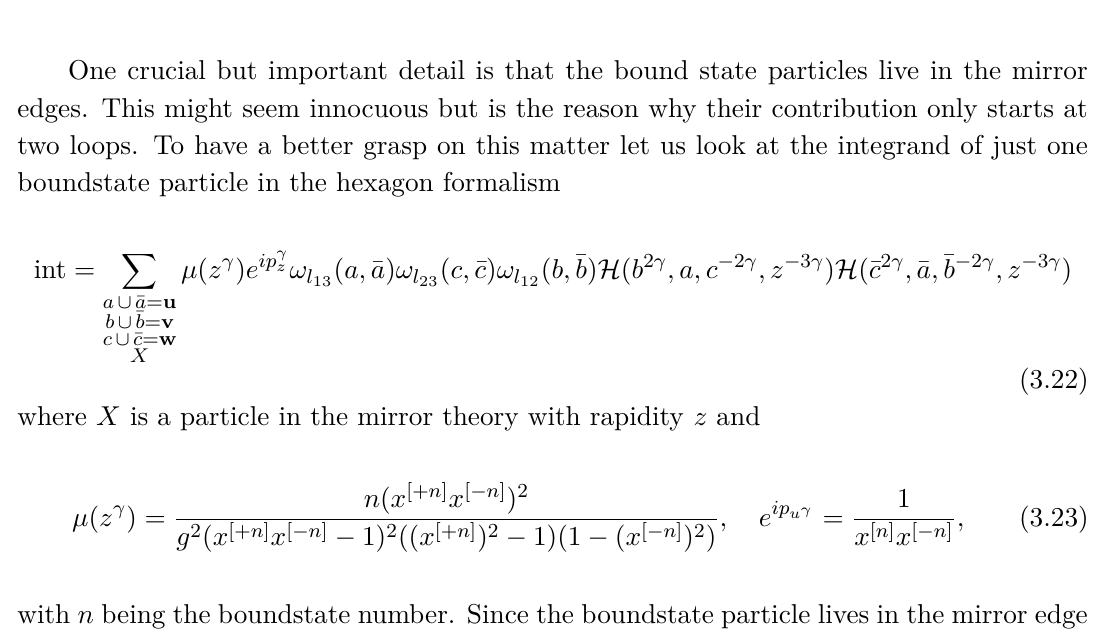
Figure 11 . Single mirror particle contribution to a three point function with three spinning operators. The mirror particle would correspond to a bottom contribution (in the notation of [1, 2]) if the operators 2 , 3 were BPS and adjacent if the 1 and 2 or 3 were